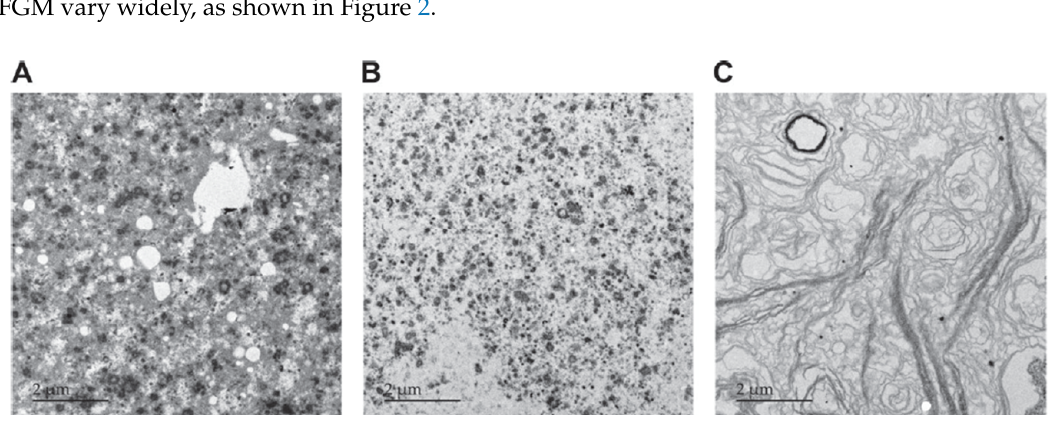
Figure 2. Electron microscope image of three different commercial ingredients containing MFGM. Each sample varies in composition and concentration of phospholipids and in structure. However, all of them have been used successfully in food products all over the world (adapted from ref [2]).